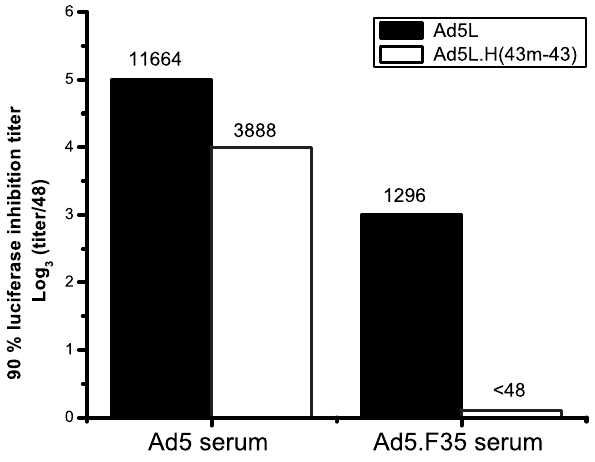
Figure 3. Ad5L.H(43-43) is not neutralized efficiently by Ad5 NAb from mice. Mice were immunized with two administrations (1 6 10 10 pu each) of adenovector at an interval of one month. The serum from these mice obtained three weeks after the last immunization was pooled, diluted 1:48 and then 3-fold serial dilutions were tested for neutralizing activity toward an unmodified Ad5L vector and the Ad5L.H(43 m-43) hexon-modified vector. Two different adenovectors were used to immunize mice and generate serum, an Ad5 vector (Ad5) and an Ad5 vector with an Ad35 fiber replacement